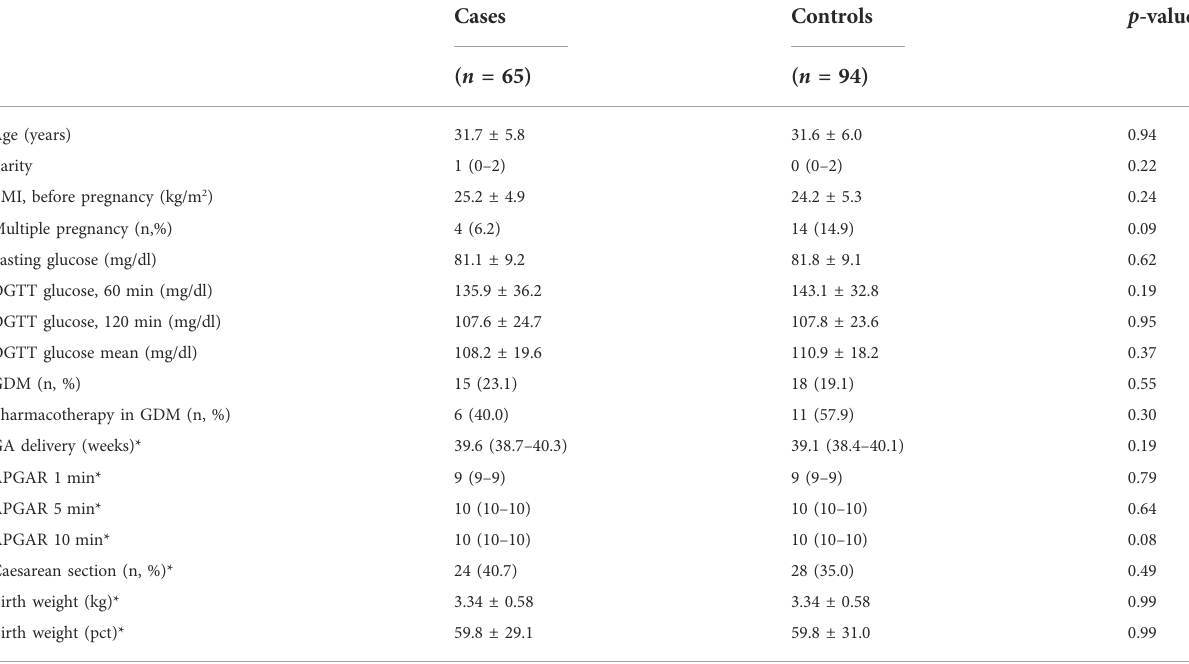
TABLE 1 Maternal characteristics, OGTT data, obstetrical and neonatal outcomes for the group of women with history of SARS-CoV-2 infection (cases) and the group without infection (controls).